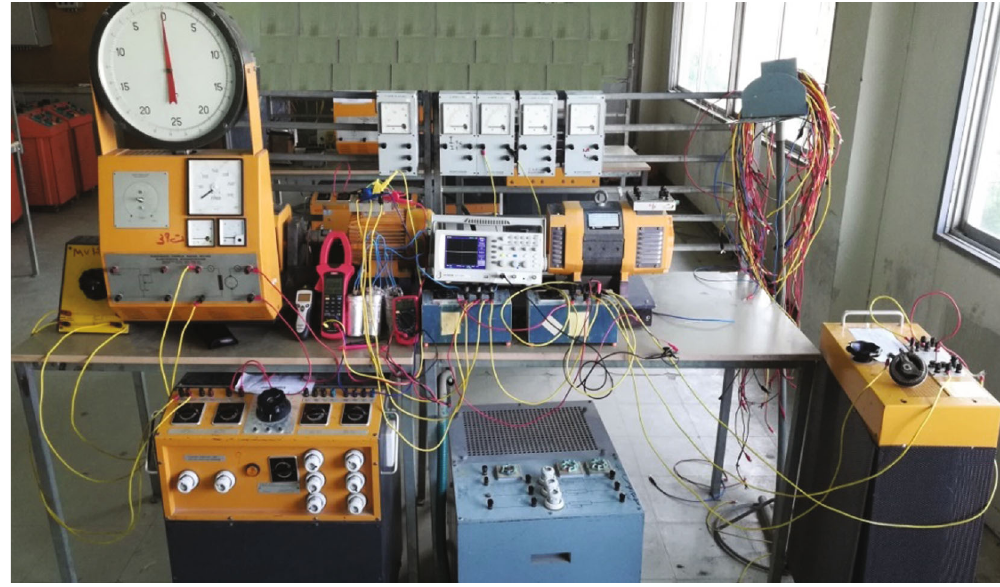
Figure 4: The experimental setup.